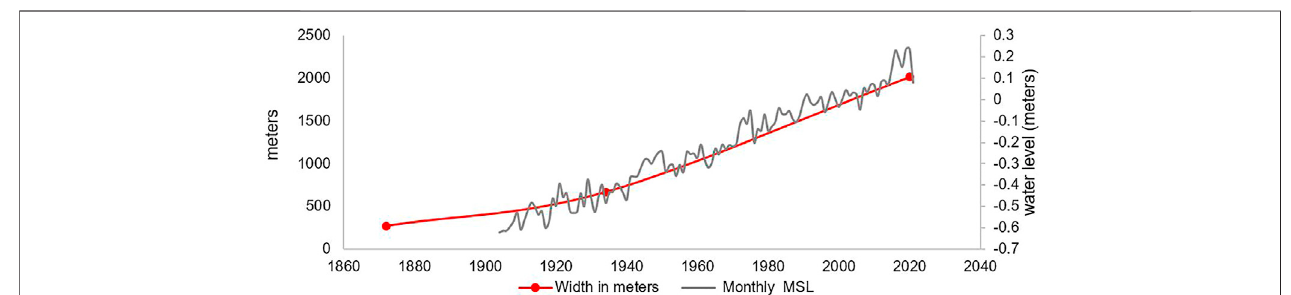
FIGURE 6 | Shoreline change from 1872 to 2018.